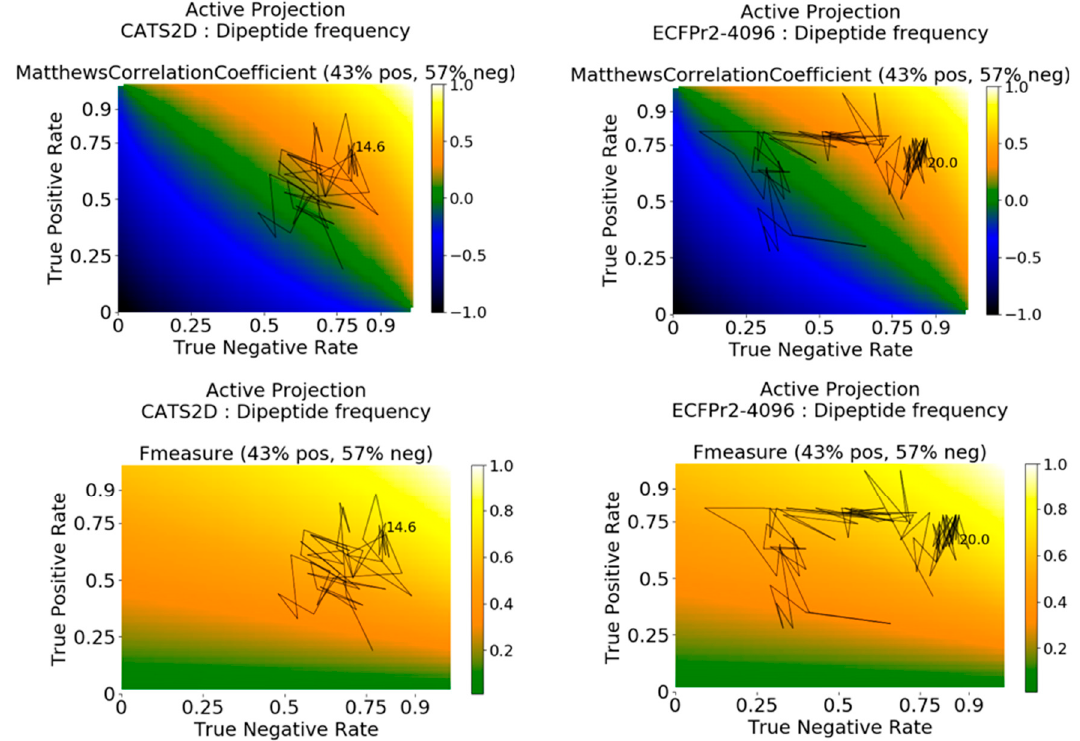
Figure 3. Active projections decompose the evolution of active learning into active and inactive prediction rates in an iteration-dependent fashion, in addition to the primary metric. Here, the active projection of probe molecule profile performance is shown for the MCC ( top ) and F1 ( bottom ) metrics. The ratio of active to inactive annotations is used in generating metric surfaces for each type of metric used, guiding interpretation about the range of possible values under such ratio. Active projections terminate when no substantial change (here: 0.075) in either TPR or TNR can be achieved, and the final amount of training data at projection termination is given.